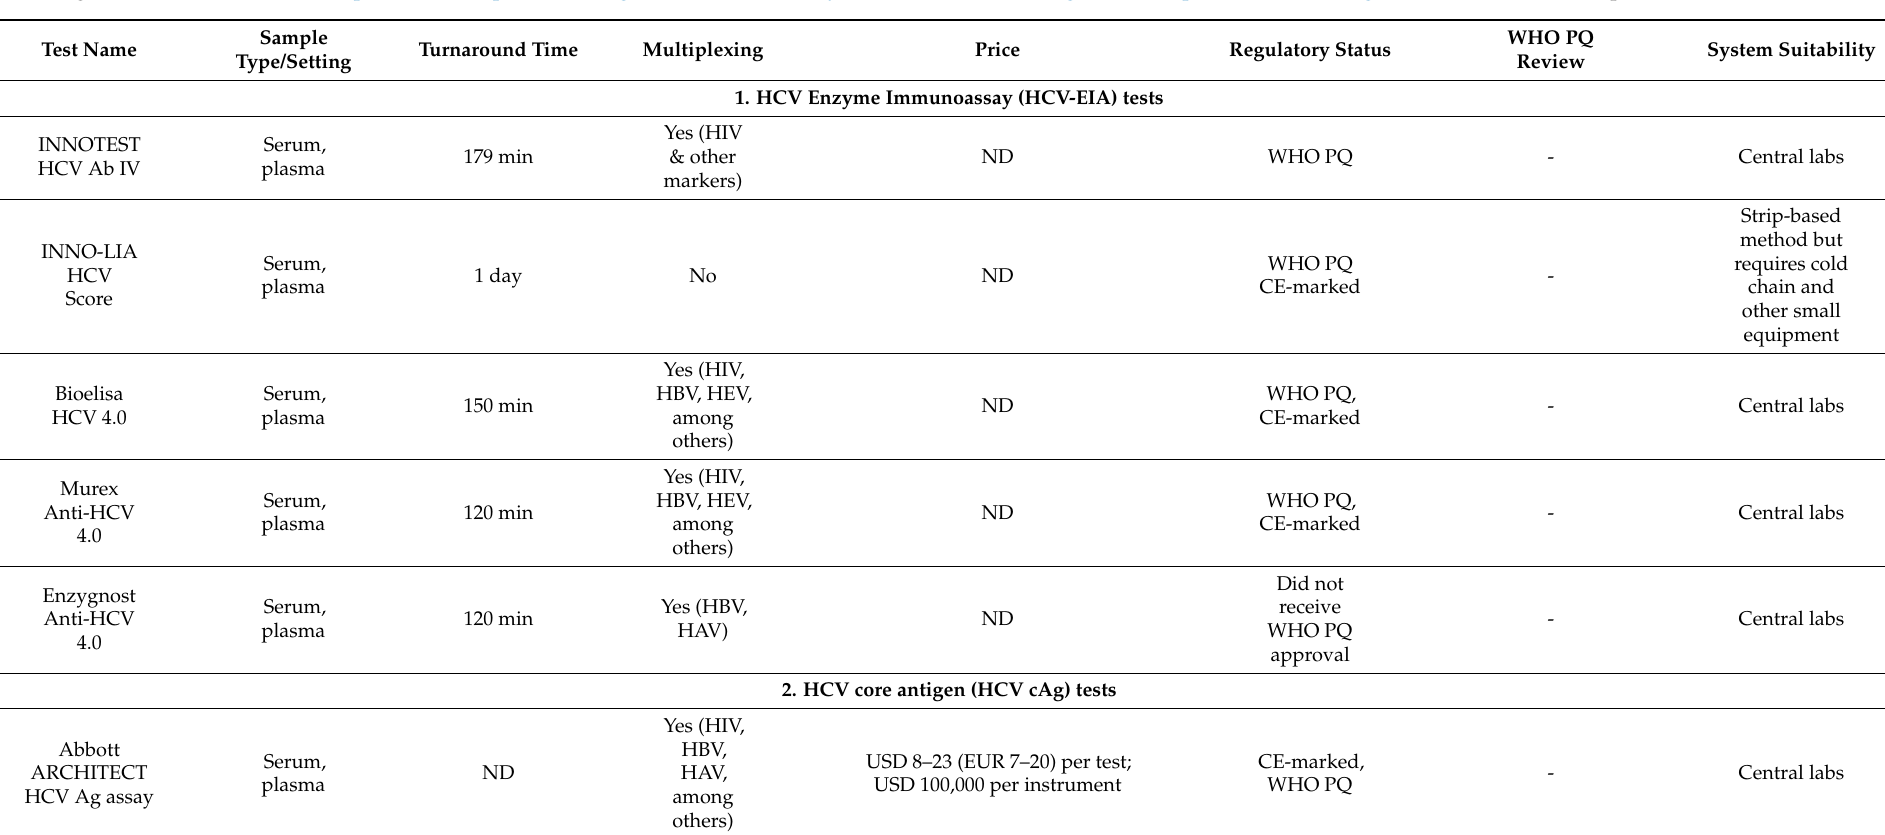
Table 2. The WHO essential diagnostic list of current and emerging HCV diagnostic platforms and tests with WHO prequalification, are CE marked, and are in late-stage development. ND = not defined, PQ = prequalification, CE = Conformit è Europëenne, LMICs = low-to-middle-income countries, CE-IVD = Conformit è Europëenne in vitro diagnostics, POC = point of care, NAT = nucleic acid testing, HAV = hepatitis A virus, IVD= in vitro diagnostics, TB = tuberculosis, GTs = genotyping, TK = to come. (Source: Activist Guide to Hepatitis C